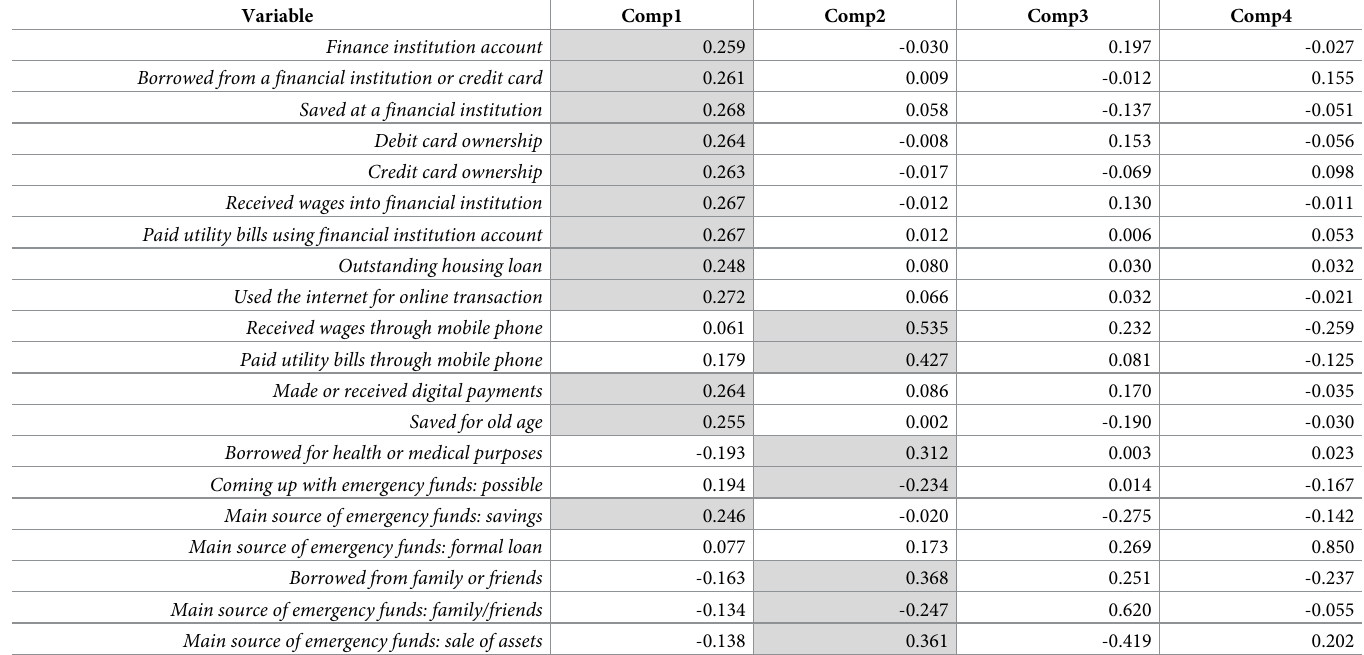
Table 4. Principal components’ correlation with original Global Findex